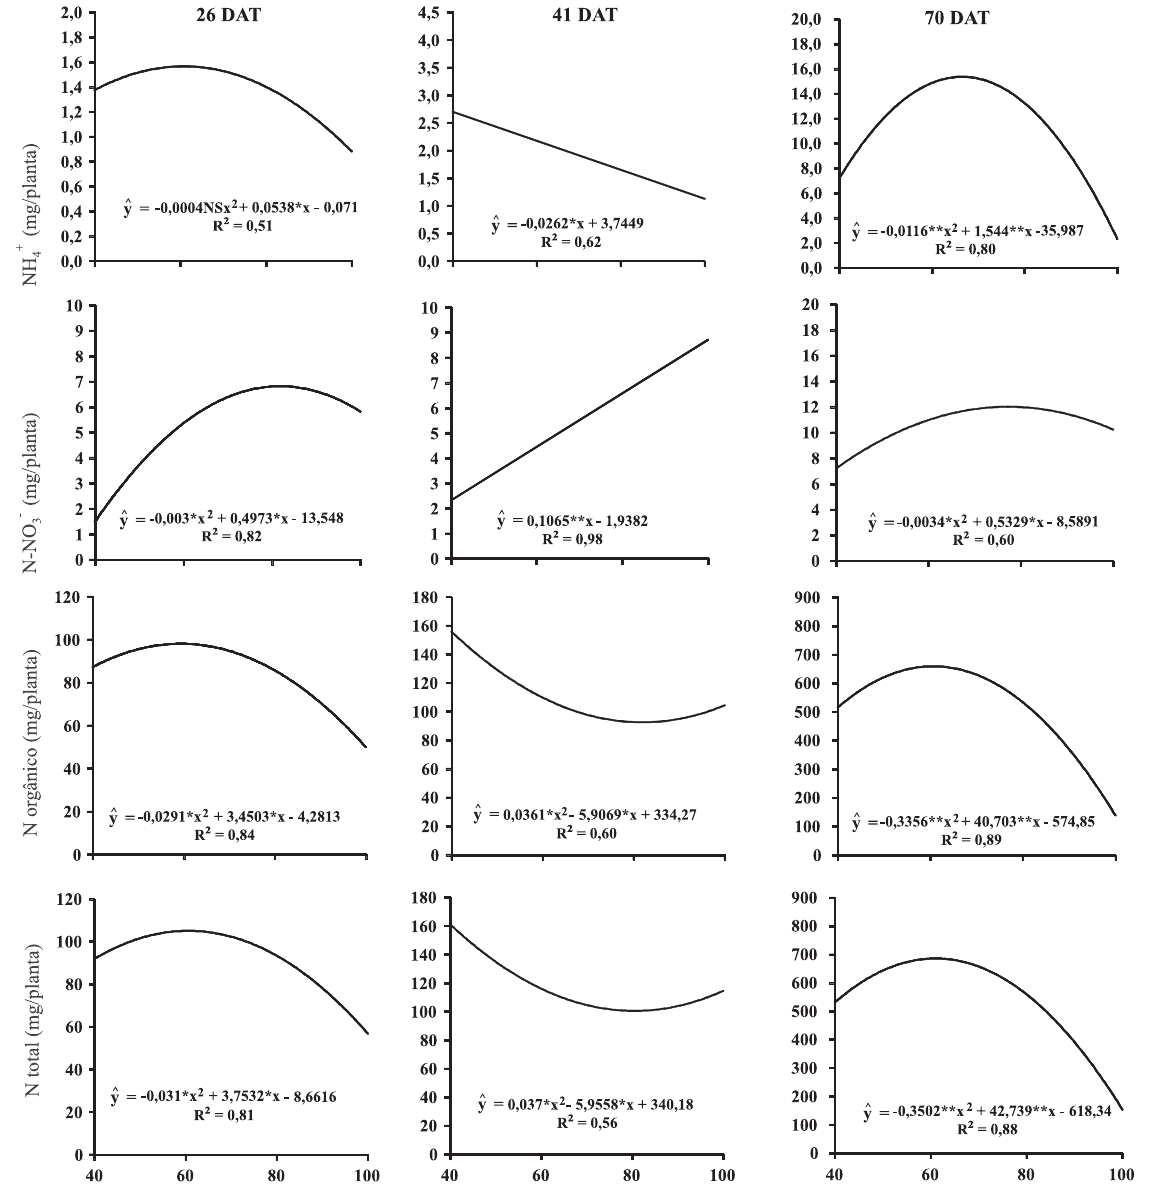
figura 5. totais acumulados de nitrogênio total (n-total), orgânico (n-org), nítrico (n-no 3- ) e amoniacal (n-nH 4+ ) na matéria seca da cultivar brsmG Conai em função das proporções de nitrato e dos estádios de crescimento. 1 dAt: dias após o transplantio. ** ,* e ns: significativo em níveis de p < 0,05 e p < 0,01 e não significativo,